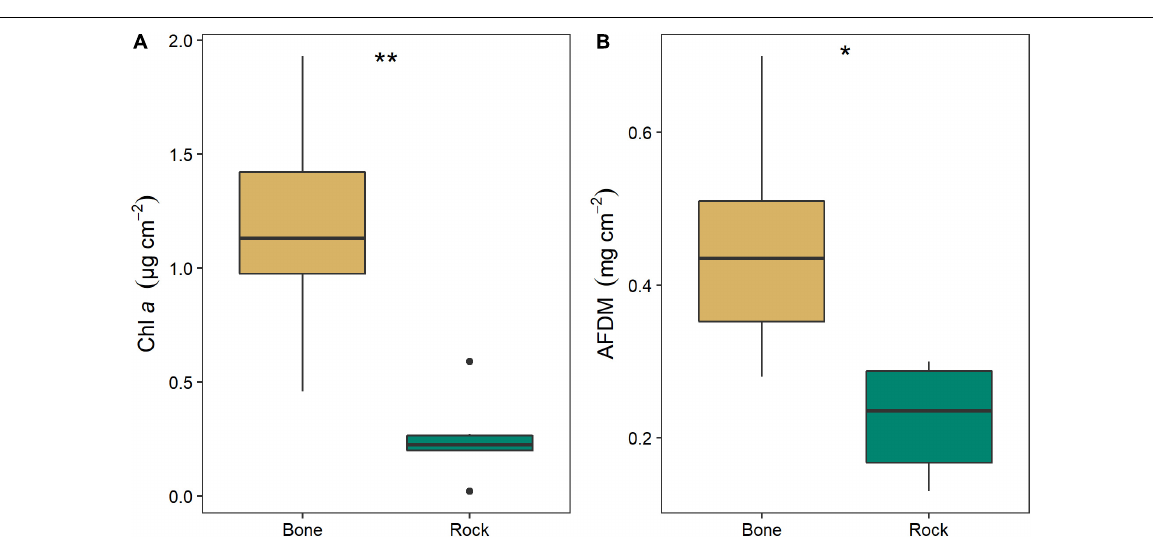
FIGURE 8 | Mean ( ± SE) values of (A) chlorophyll a and (B) organic matter as ash free dry mass (AFDM) on bone ( n = 3) and rock ( n = 3) substrates in the Mara River. Asterisks indicate significant difference, where * p < 0.05 and ** p <